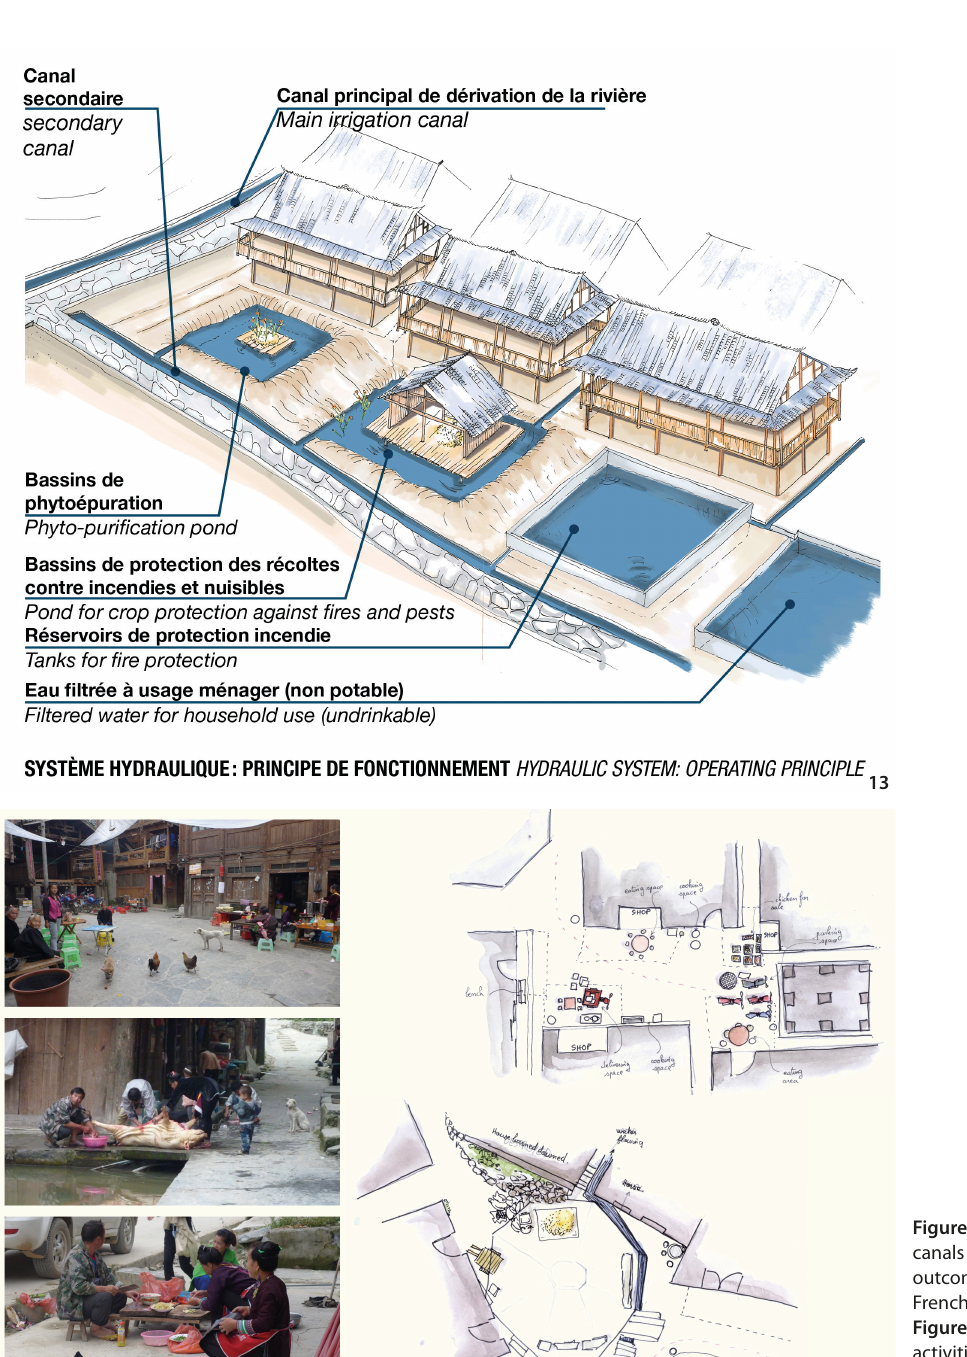
Figure 13 Analysis of ponds and canals in Zengchong (Source: outcome of Zengchong Chinese- French Workshop). Figure 14 Public space and activities in the village (Source: outcome of Zengchong Chinese- French